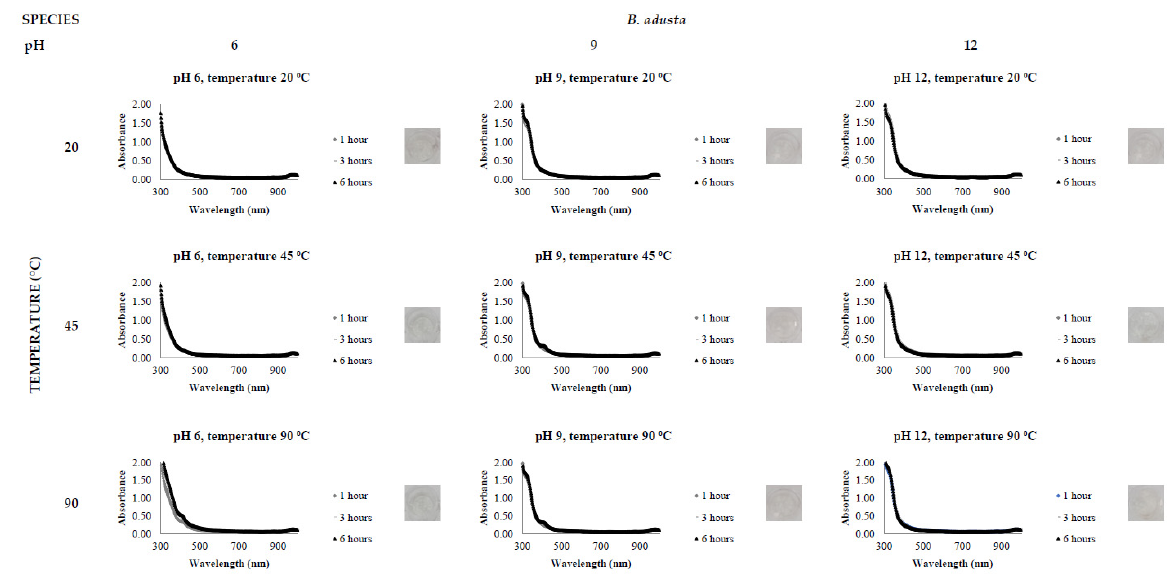
Figure 7. LSPR spectra of B. adusta cell-free extract in the synthesis of AgNPs, by the addition of 0.5 mM AgNO 3 , varying the reaction time (1, 3 and 6 h), temperature (20, 45 and 90 °C) and pH (6, 9 and 12), through UV-Vis spectrophotometry analysis.